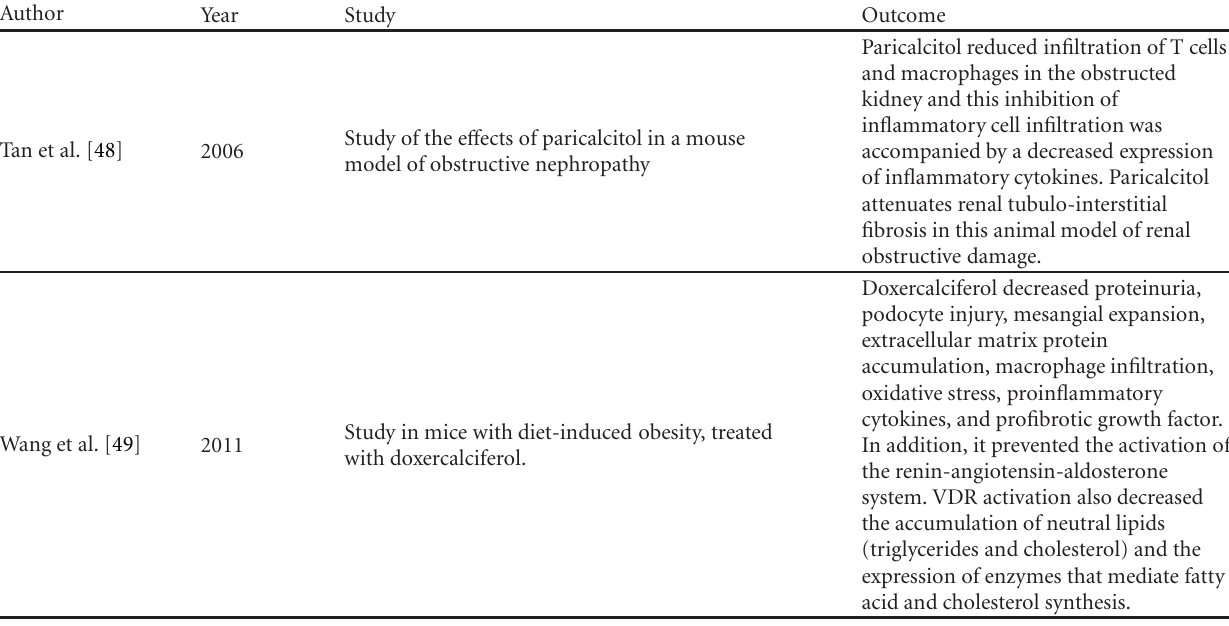
Table 12: Renal protection and reduction of tubular interstitial fibrosis.